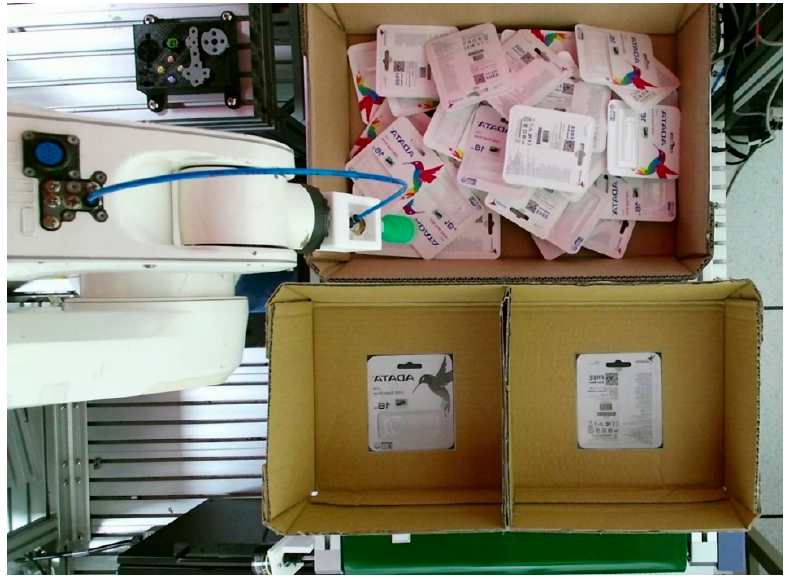
Figure 29. Set-up for evaluating the final pickup success rate. Table 9. Pickup success